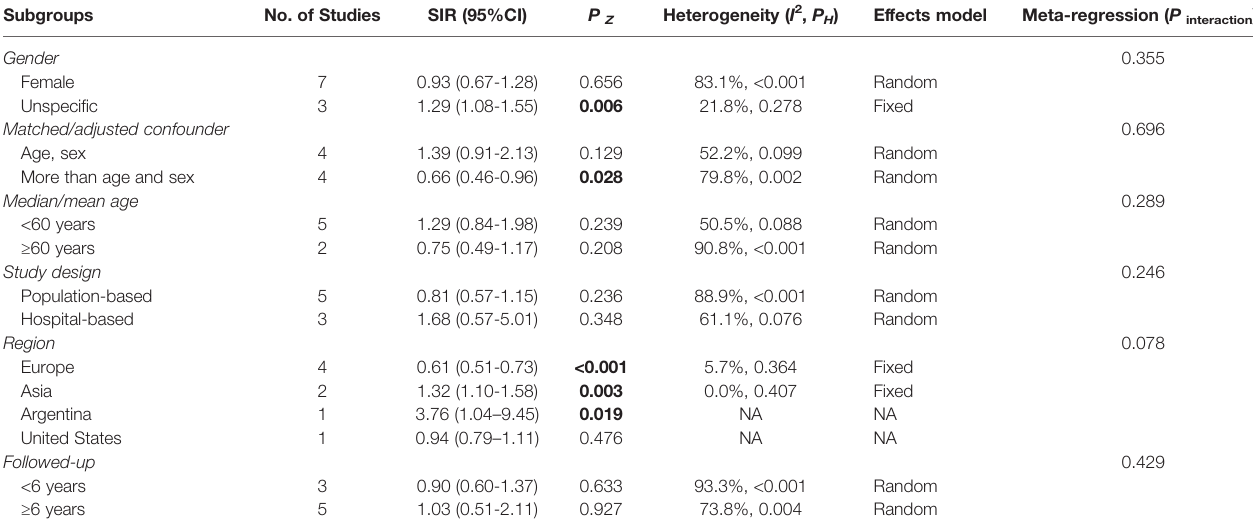
Bold indicates P values with statistical signi fi cance (<.05). SIR, Standardized incidence ratios; NA, not applicable *Multivariate meta-regression analysis for all the variables listed in this